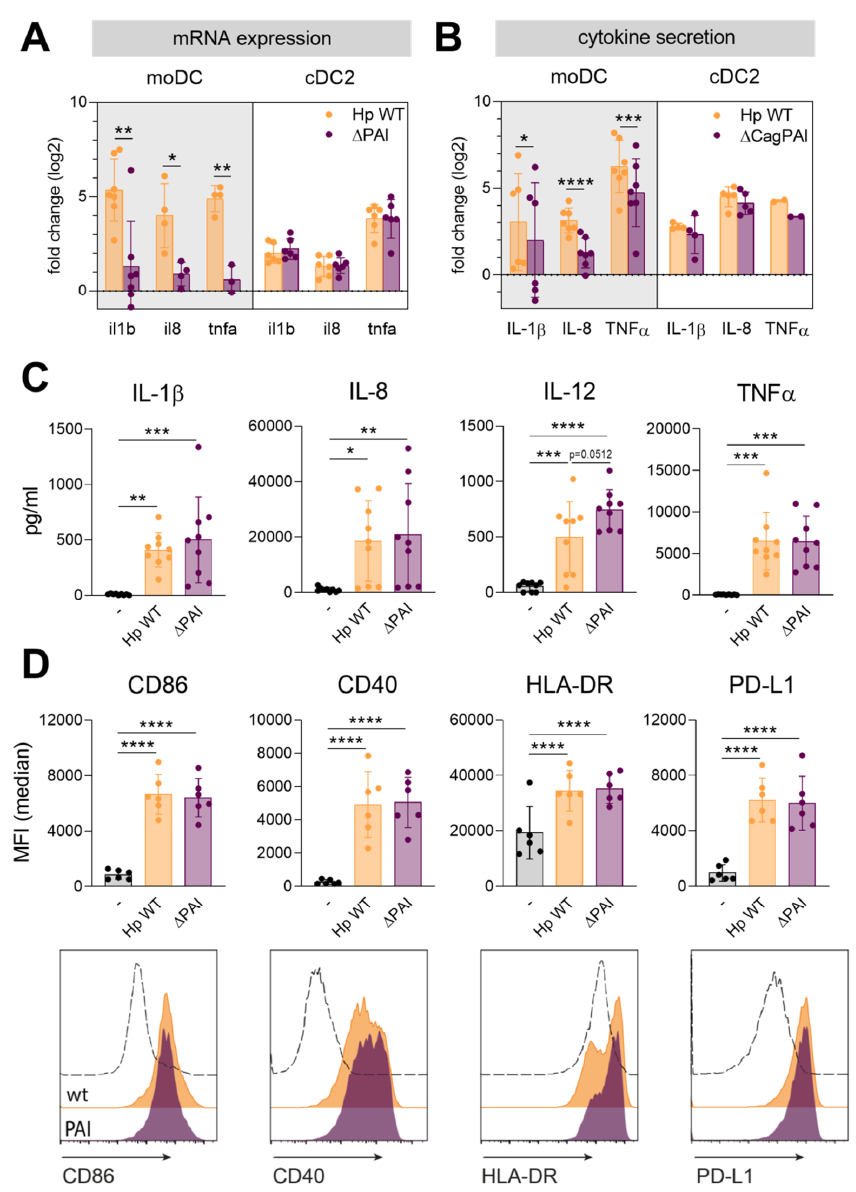
Figure 1. Activation of CD1c + conventional DC (cDC2s) is similar upon infection with Helicobacter pylori wt or a mutant lacking the T4SS. ( A , B ) Monocyte-derived DCs (moDCs) or cDC2s were infected with H. pylori wt or a mutant lacking the type IV secretion system ( ∆ PAI) at a multiplicity of infection (MOI) of 5. One hour post-infection, mRNA expression was analyzed by qPCR ( A ). After 4 h, cytokine secretion was evaluated by ELISA or multiplex technology ( B ). Log2 fold changes compared to the untreated sample are shown. For comparing fold changes of Hp wt and PAI-infected samples, a paired t-test was performed. ( C ) Cytokine and chemokine secretion by cDC2s was measured by multiplex technology 16 h post-infection. ( D ) Surface marker expression was monitored by flow cytometry. Median fluorescence intensity of six donors (upper panel) and histograms of one representative donor (lower panel) are shown. Dots represent individual donors, bars show means ± SDs. For statistical analysis, repeated-measures, one-way ANOVA with Tukey’s post-hoc test was performed. (* p ≤ 0.05, ** p ≤ 0.01, *** p ≤ 0.001, **** p ≤